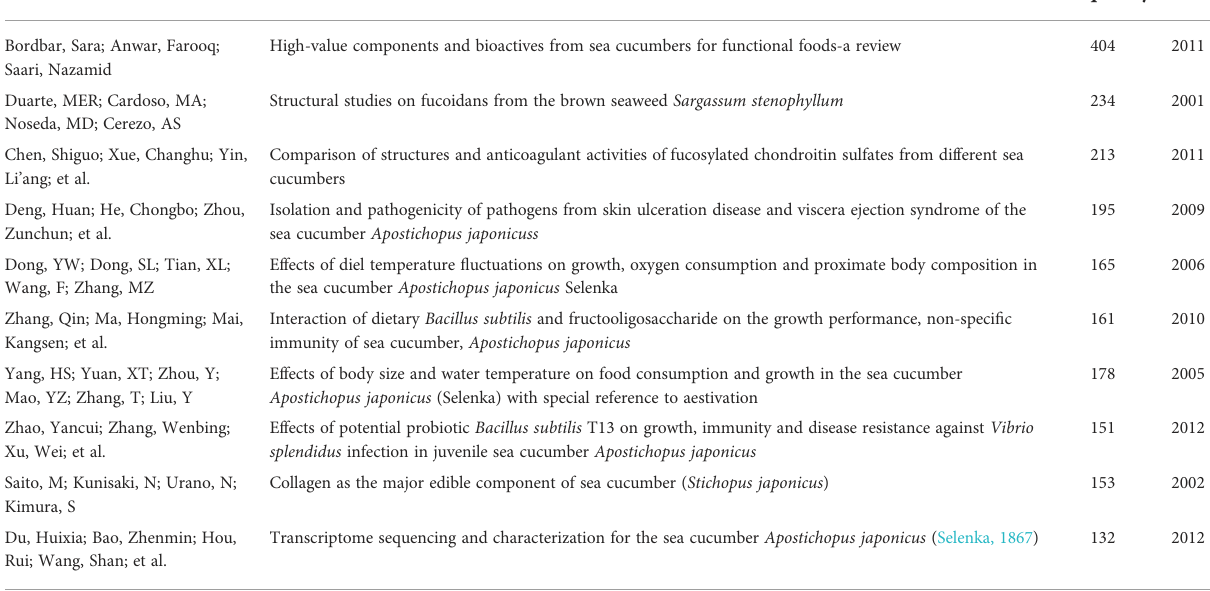
TABLE 4 The 10 most in fl uential papers in the fi eld of Apostichopus japonicus from 2000 to 2021.